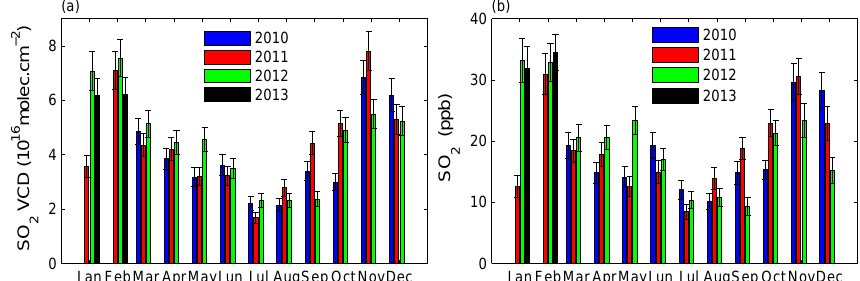
Figure 11. Monthly mean SO 2 VCD (a) and surface concentration (b) for the March 2010–February 2013